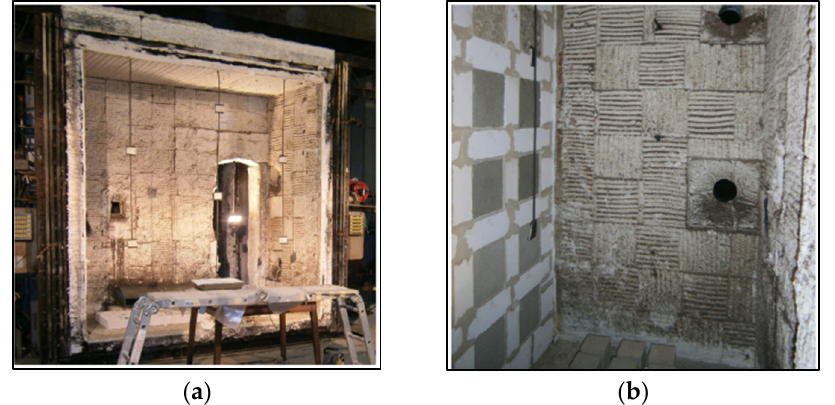
Figure 12. Fire test on cementitious composites: ( a ) furnace, and ( b ) heating side. Shah et al. conducted a fire-resistance test on confined concrete columns. The testing furnace (Figure 13) was customized to develop the temperature shape as per the ISO 834.